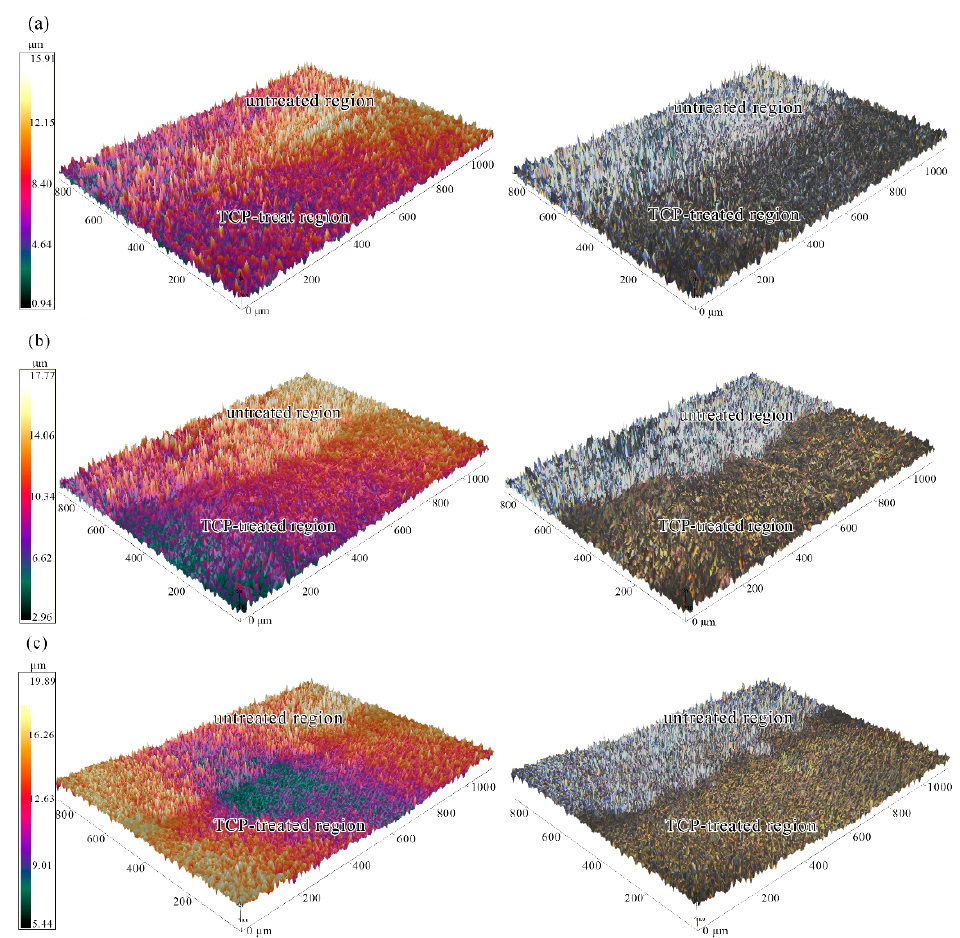
Figure 1. Surface 3D topography comparison of untreated and TCP-treated regions within one Zn55Al specimen surface with different immersion periods: ( a ) 30 s; ( b ) 180 s; ( c ) 360 s at 40 ° C in the TCP bath.